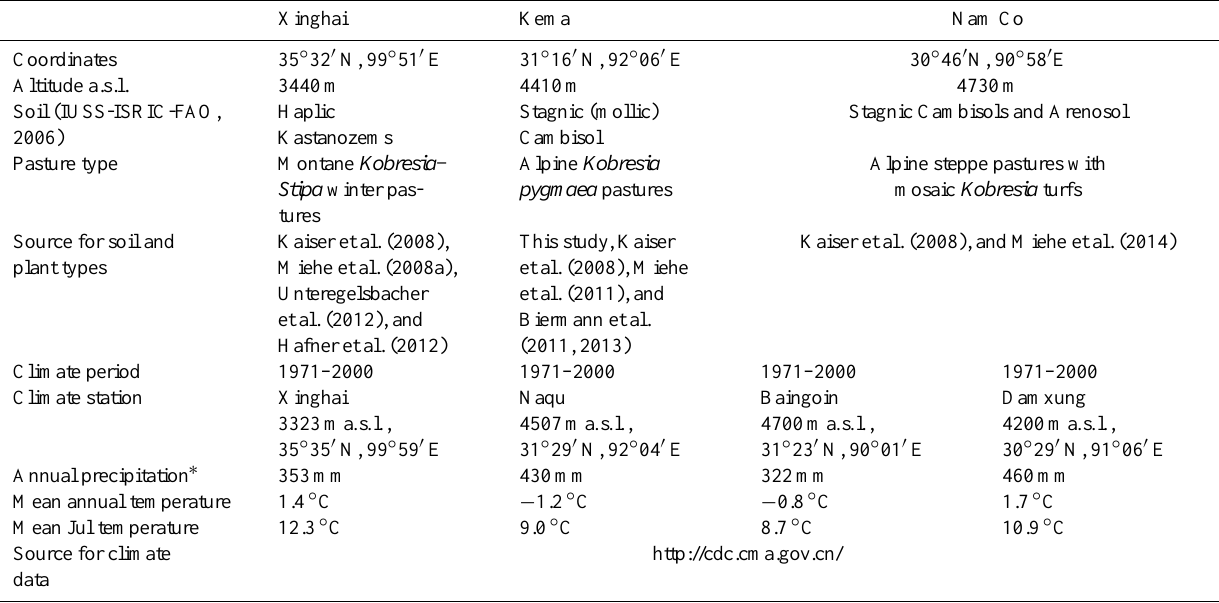
Table 1. Characteristics of the three study sites.